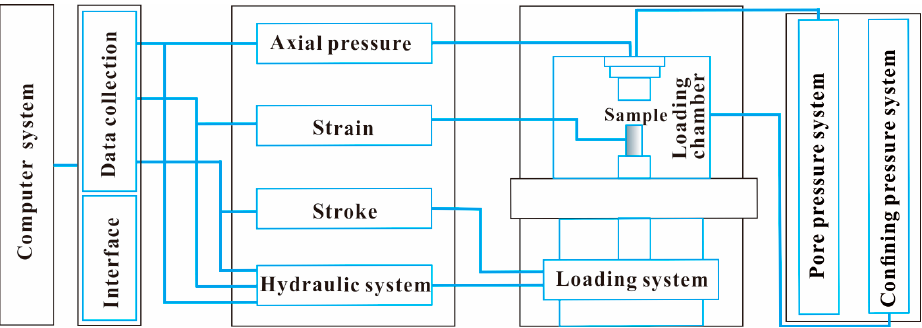
Figure 6. Structure diagram of Mechanics Testing System.